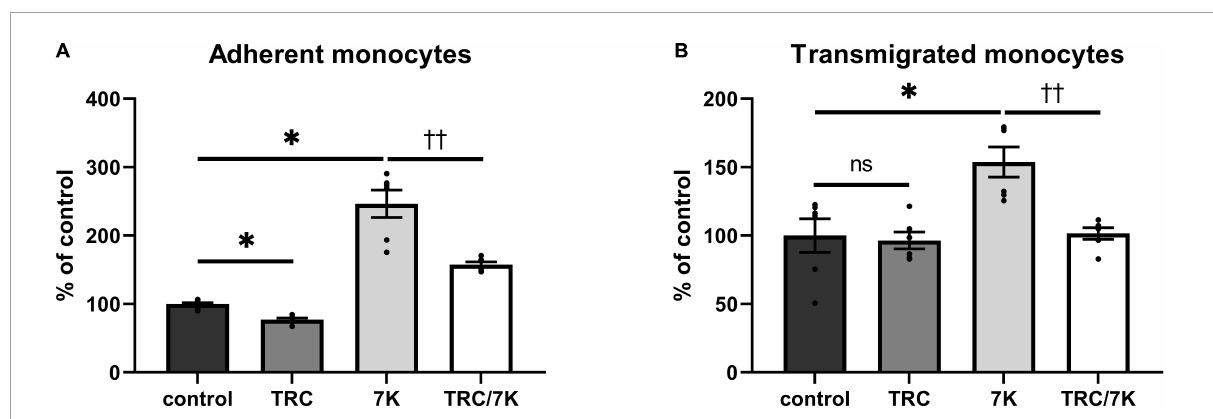
FIGURE5 Effect of TRC105 on 7K-induced adhesion and transmigration of monocytes through monolayers of HAoECs. (A) adherent monocytes; (B) transmigrated monocytes. For the detailed experimental design, please see Figure 1 . The data are presented as mean ± S.E.M ( n = 6). ns, p ≥ 0.05; * p < 0.05, using Kruskal–Wallis test for comparisons among control, TRC and 7K, and †† p < 0.01, using Mann–Whitney test for comparison between 7K vs